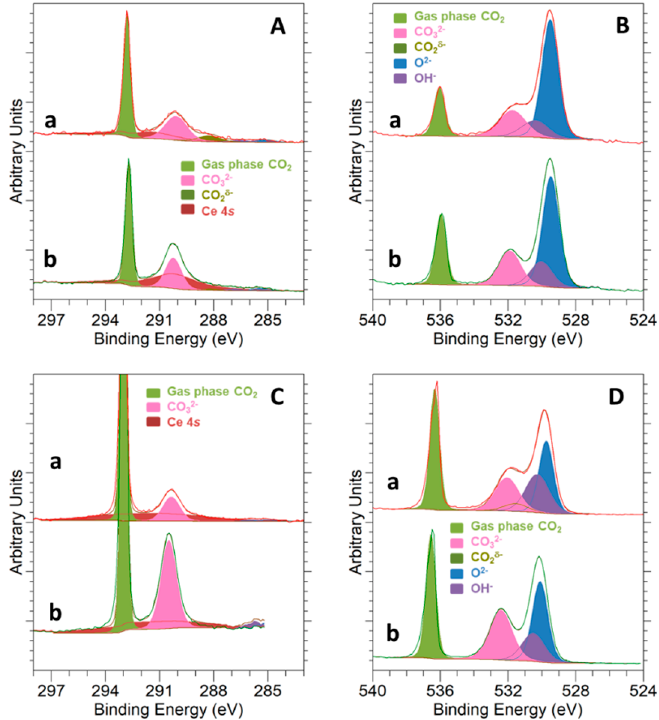
Figure 7. NAP-XPS spectra for C 1 s at KE = 550 eV and KE = 190 eV ( A ) and ( C ) and O 1 s at KE = 550 eV and KE = 190 eV ( B ) and ( D ) corresponding to (a) 5Ni-CeO 2 NCs and (b) CeO 2 NCs under 1 mbar CO 2 at a temperature of 250 °C.